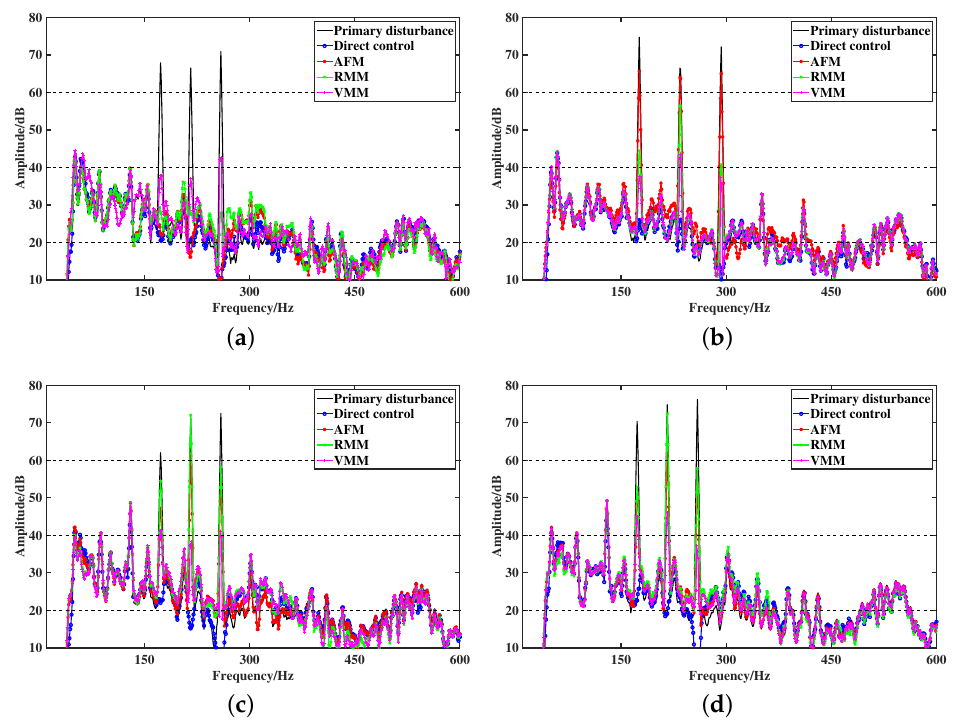
Figure 8. Amplitude spectrum at the left ear of the dummy head under various algorithms and disturbance configurations. ( a ) First disturbance configuration. ( b ) Second disturbance configuration. ( c ) Third disturbance configuration. ( d ) Fourth disturbance